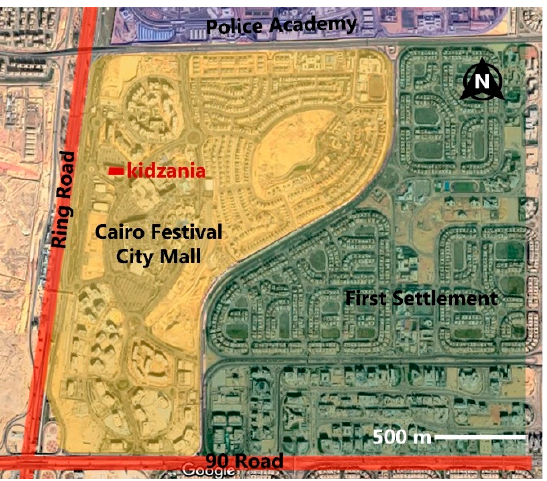
Figure 1. The context of Kidzania’s branch in Cairo Festival city Mall in Egypt. Source(s): Based on Google Maps (2022).